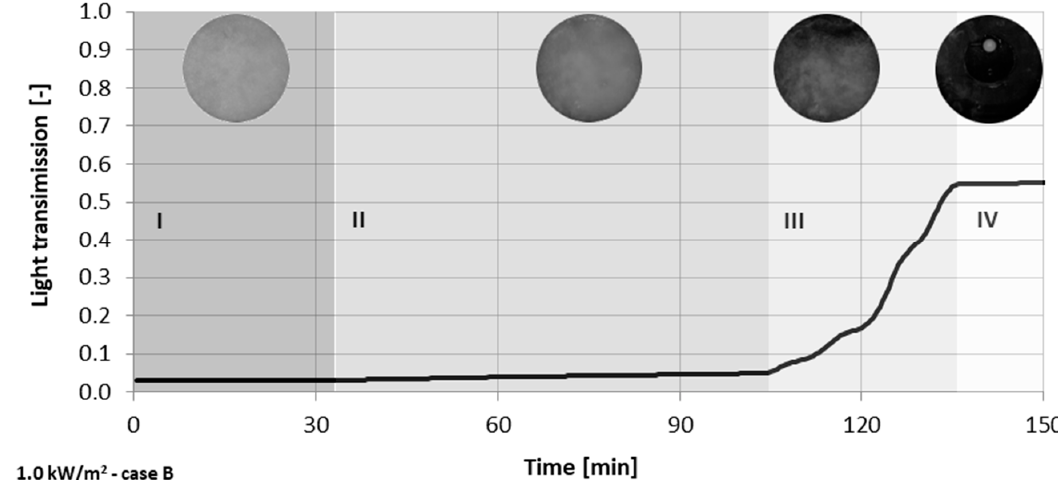
Figure 7. Direct light transmission versus time for an irradiance of 1000 W/m 2 , case A.